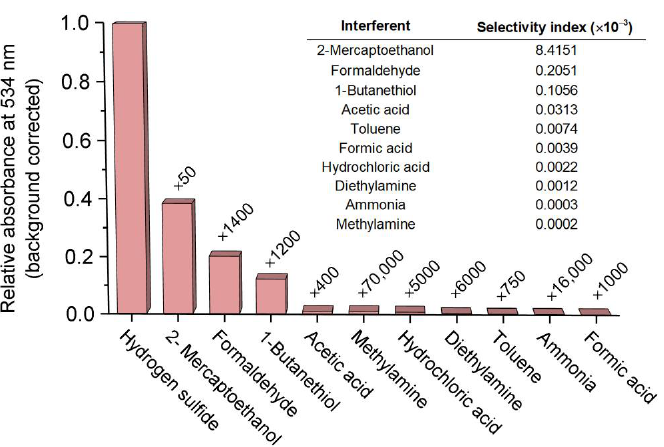
Figure 3. Effects of various saturated vapors on the absorbance at 534 nm of the paper strip con- taining (NBD) 2 S. H 2 S was considered as a reference with a concentration of 50 ppm. The relative concentrations of the interferents are denoted on top of each bar. The inset chart shows the selectivity index for each vapor as defined in the text.